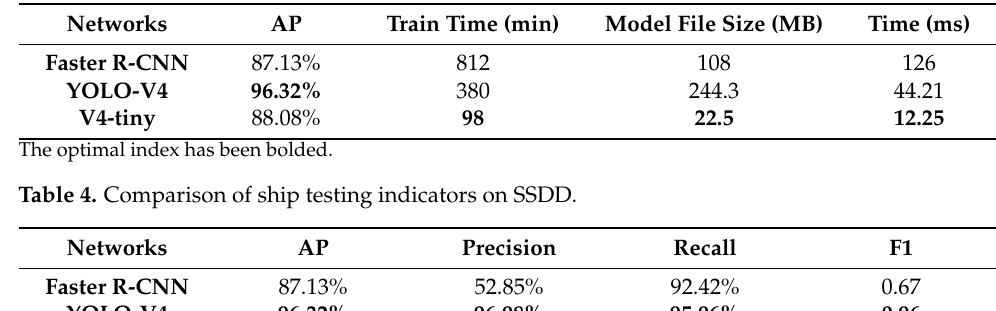
Table 3. Comparison of ship testing indicators on SSDD.